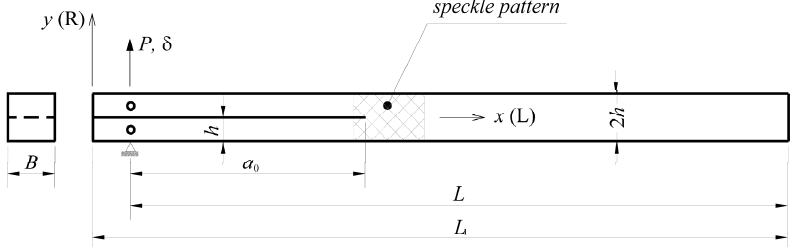
Figure 1: Schematic representation of the DCB test ( 2 h = 20